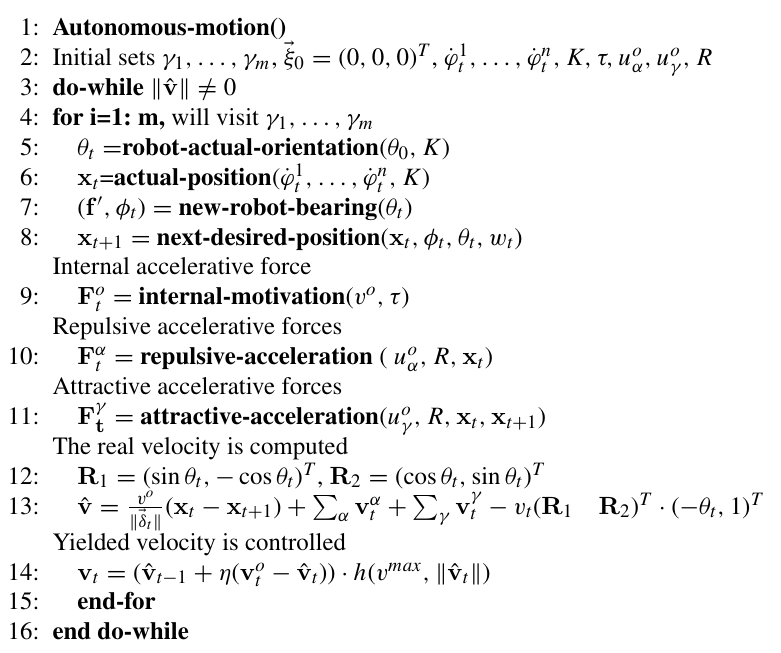
Table 9 Algorithm Social directional field navigation